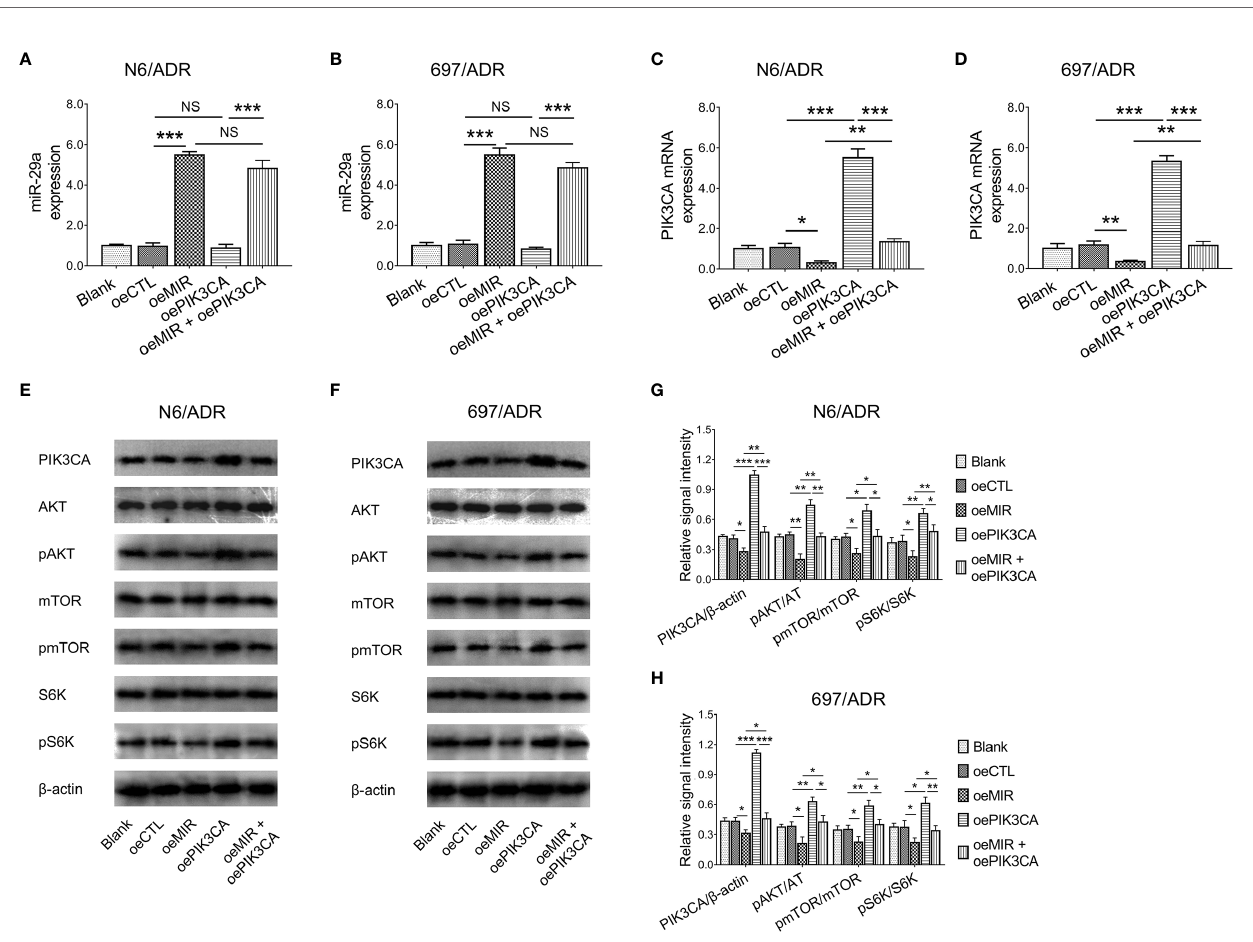
FIGURE 7 | Interaction among miR-29a, PIK3CA , and PI3K-AKT-mTOR signaling. MiR-29a (A, B) and PIK3CA (C, D) expressions among blank, oeCTL, oeMIR, oePIK3CA, and oeMIR + oePIK3CA groups in N6/ADR cells and 697/ADR cells. PI3K-AKT-mTOR signaling among blank, oeCTL, oeMIR, oePIK3CA, and oeMIR + oePIK3CA groups in N6/ADR cells and 697/ADR cells (E – H)